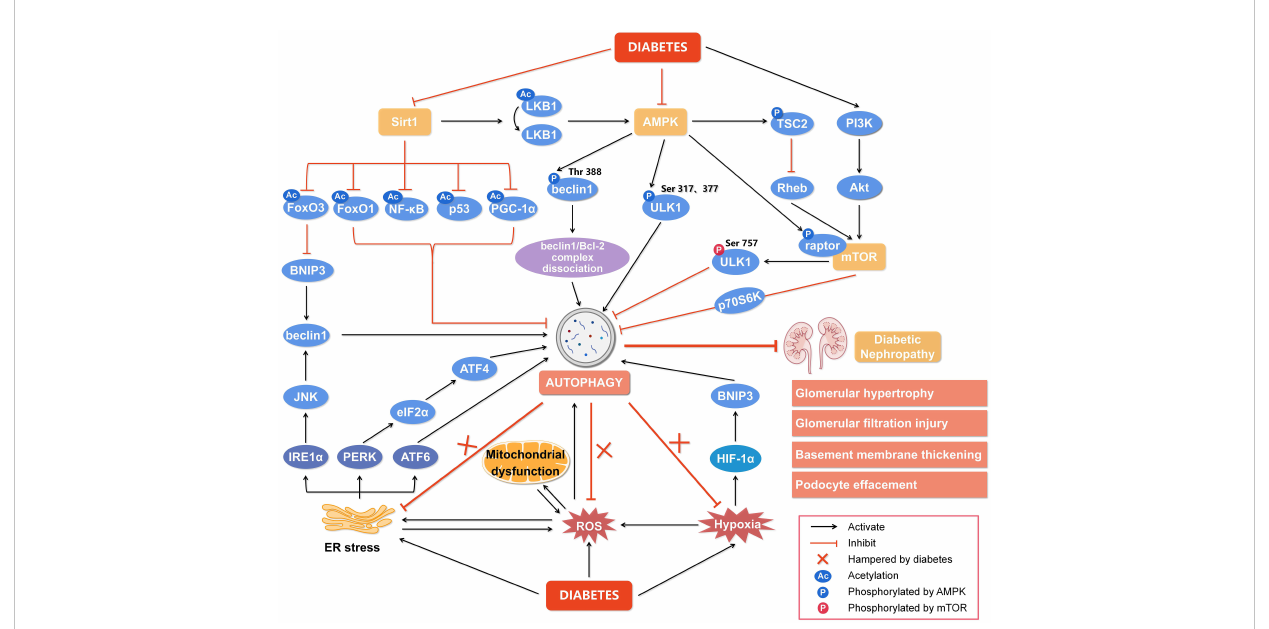
FIGURE 2 Regulation of autophagy during diabetic nephropathy. Hyperglycemia is considered a state of overnutrition, leading to over-activation of the mammalian target of rapamycin (mTOR) and inhibition of adenosine 5 ’ -monophosphate-activated protein kinase (AMPK) and silent information regulator of transcription 1 (Sirt1). The activated mTOR inhibits autophagy by blocking unc-51-like kinase 1 (ULK1) activation by AMPK and its downstream target phosphoprotein 70 ribosomal protein S6 kinase (p70S6K). The inhibition of AMPK blocks the dissociation of the beclin1/Bcl-2 (B- cell lymphoma-2) complex and the phosphorylation of ULK1, while promotes mTOR activity to reduce autophagy. The inactivated Sirt1 reduces the deacetylation of several target genes like forkhead box O3 (FoxO3), FoxO1, nuclear factor kappa-B (NF- k B), p53, and peroxisome proliferator- activated receptor-gamma coactivator-1 a (PGC-1 a ) to inhibit autophagy. In addition, other cellular events, including reactive oxygen species (ROS), endoplasmic reticulum (ER) stress, and hypoxia, can also regulate autophagy to affect the development of diabetic nephropathy. Hypoxia-inducible factor 1 a (HIF-1 a ) induced by hypoxia promotes the transcription of Bcl-2/adenovirus E1V19-kDa interacting protein 3 (BNIP3) and induces autophagy. ER stress enhances the expression of ER membrane proteins like protein kinase RNA-like ER kinase (PERK), inositol-requiring enzyme 1 a (IRE1 a ), and activating transcription factor 6 (ATF6), leading to autophagy. In addition, autophagy under ER stress may be associated with the signaling pathway of PERK/ a -subunit of eukaryotic initiation factor 2 (eIF2 a )/ATF4 and IRE1 a /c-Jun N-terminal kinase (JNK)/beclin1. Signi fi cantly, the endogenous autophagy induced by ER stress, oxidative stress and hypoxia in diabetes is hampered, which aggravates the progression of diabetic nephropathy. Thus, impaired autophagy accelerates the progression of diabetic nephropathy, resulting in a series of renal pathological damages. Rheb, ras homolog enriched in brain; PI3K, class III phosphatidylinositol-3-kinase; Akt, protein kinase